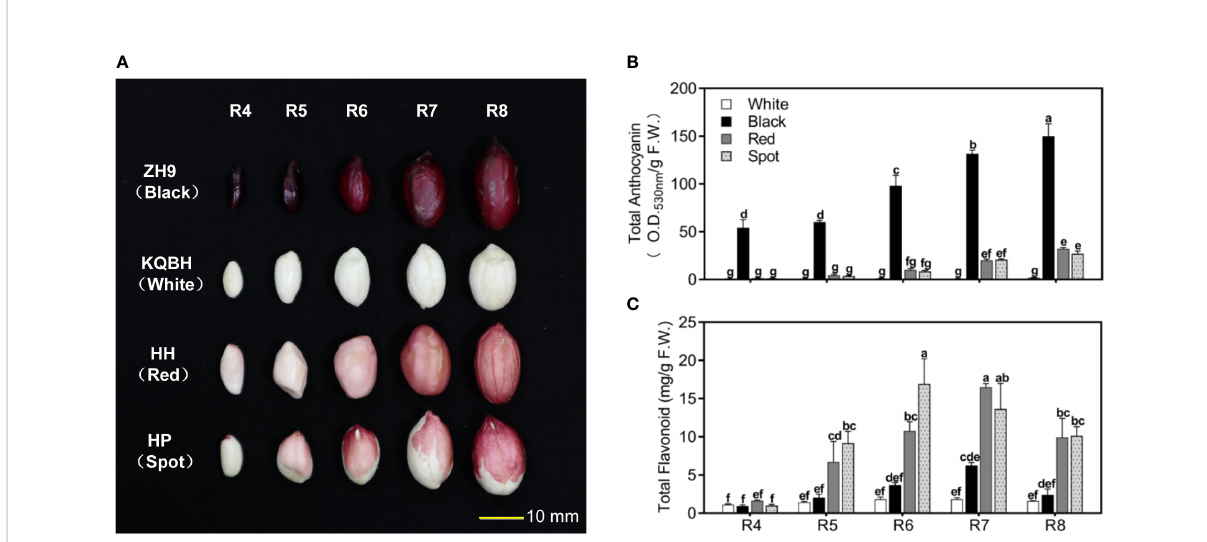
FIGURE 1 Phenotypic characterization of peanut seed coat at different pod developmental stages. (A) The morphological observation of peanut seed with different testa color (red, black, white and spot) from full pod stage (R4) to harvest maturity stage (R8). Analysis of total anthocyanin contents (B) , and total fl avonoid contents (C) in peanut testa at different stages of development using spectrophotometric methods. Multiple comparisons in one-way ANOVA were done by Duncan grouping using SPSS Statistics tool (v22, IBM). Different letters marked in the fi gure indicate the difference among different samples as well as developmental stages. The bars correspond to standard errors of three biological